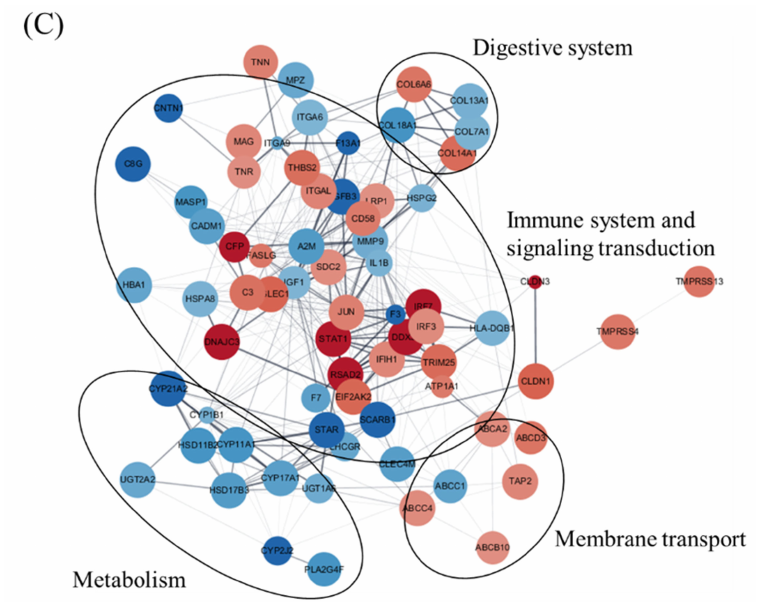
Figure 2. Protein–protein interaction network analysis of DEGs. Control vs. IHNV. The STRING database analyzed the protein–protein interaction network based on the proteins matching the selected DEGs on days 1 ( A ), 3 ( B ), and 5 ( C ). The protein interaction relationship of DEGs existing in the string database was selected for the network formation. The red color indicates upregulated genes; the blue color indicates downregulated genes. Node sizes are proportional to p -values. Table 6. The top ten nodes of centrality analysis of the PPI network in the IHNV injected